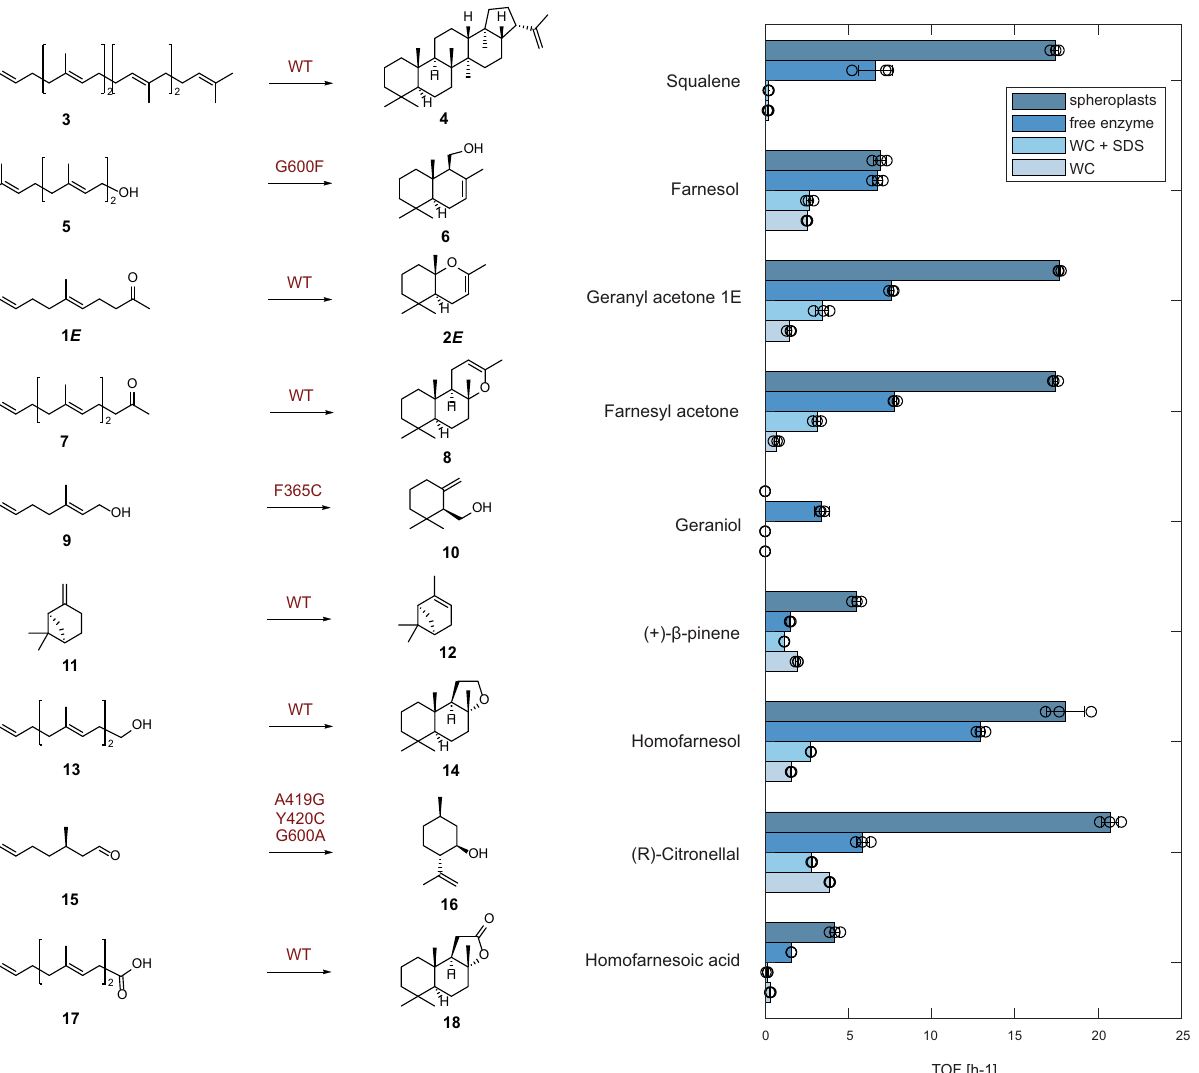
Fig. 4 | Squalene-hopene-cyclase-catalyzed cyclization of a set of terpenoids. Squalene 3 , E-farnesol 5 , E-geranyl acetone 1E , E,E-farnesyl acetone 7 , E-geraniol 9 , (+)- β -pinene 11 ,E,E-homofarnesol 13 ,(R)-citronellal 15 ,andE,E-homofarnesoicacid 17 were used as substrates employing the WT (wildtype) enzyme and the variants G600F, F365C, orA419G/Y420C/G600A asWC (wholecells),WCtreatedwith SDS, cell-free enzyme or spheroplasts. The biocatalyst preparations were compared regardingtheirTOF(turnoverfrequencyperhour).Reactionconditions:40g CWW /L